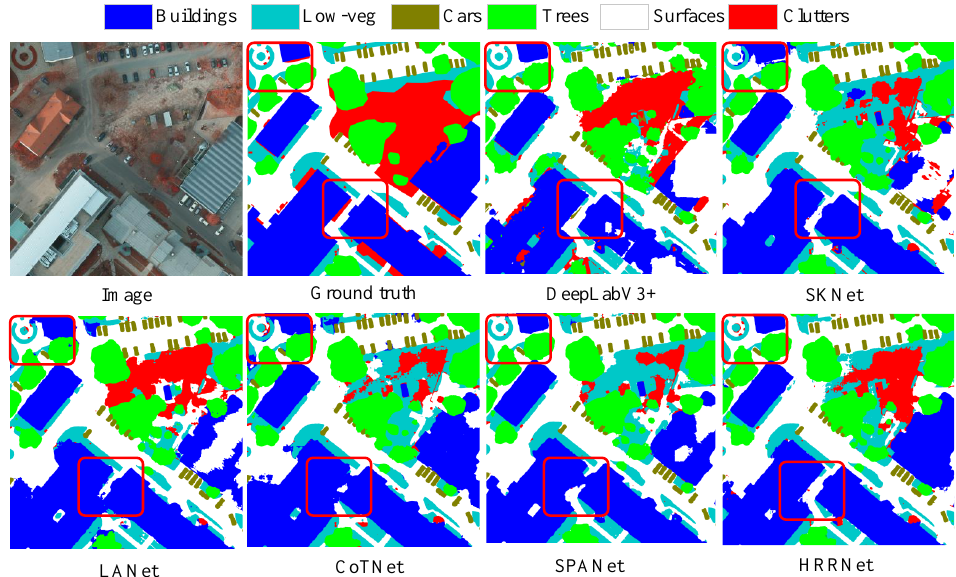
Figure 7. Visual segmentation maps for various models. These maps were the selected results on the Potsdam